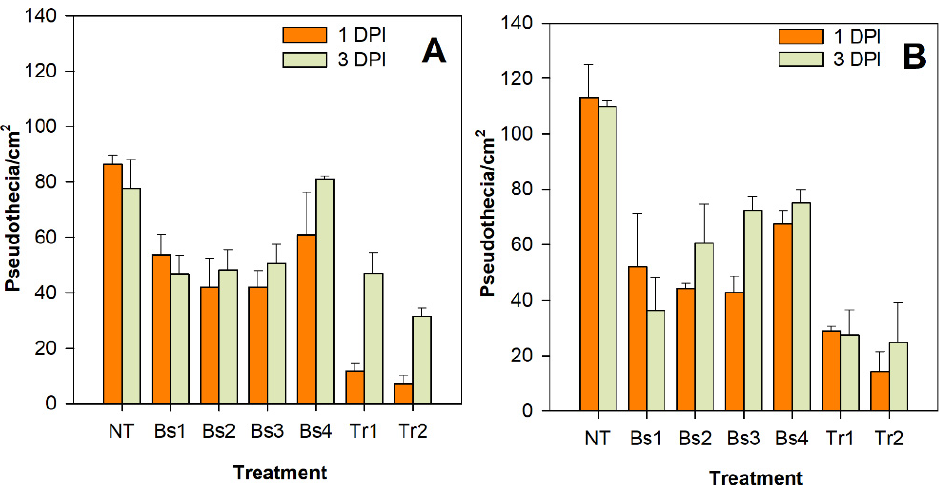
Figure 2. Effect of biological control agents (BCAs) applied 1 or 3 days after Stemphylium vesicarium inoculation (DPI) in the pseudothecia of Pleospora allii production. BCAs used were Bacillus subtilis strains (Bs1, Bs2, Bs3, Bs4) or Trichoderma spp. strains (Tr1, Tr2). NT: non-treated control. Results are given as the means and standard error (( A ): experiment 1, ( B ): experiment 2). Bars with the same letter are not significantly different according to Fisher’s protected least significant test ( p < 0.01). Lower case letters correspond to 1 DPI and upper case letters to 3 DPI